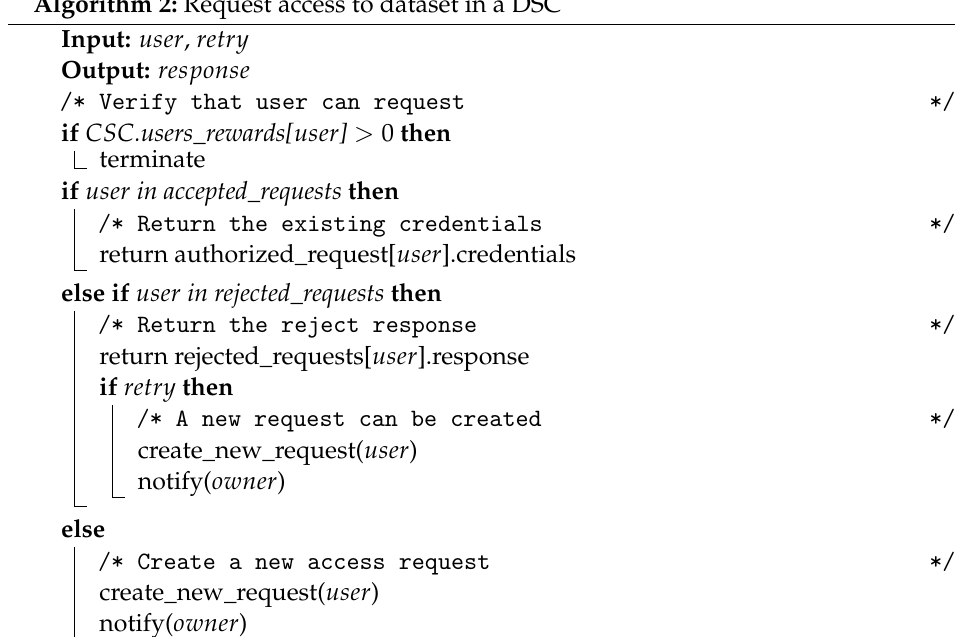
Algorithm 2: Request access to dataset in a